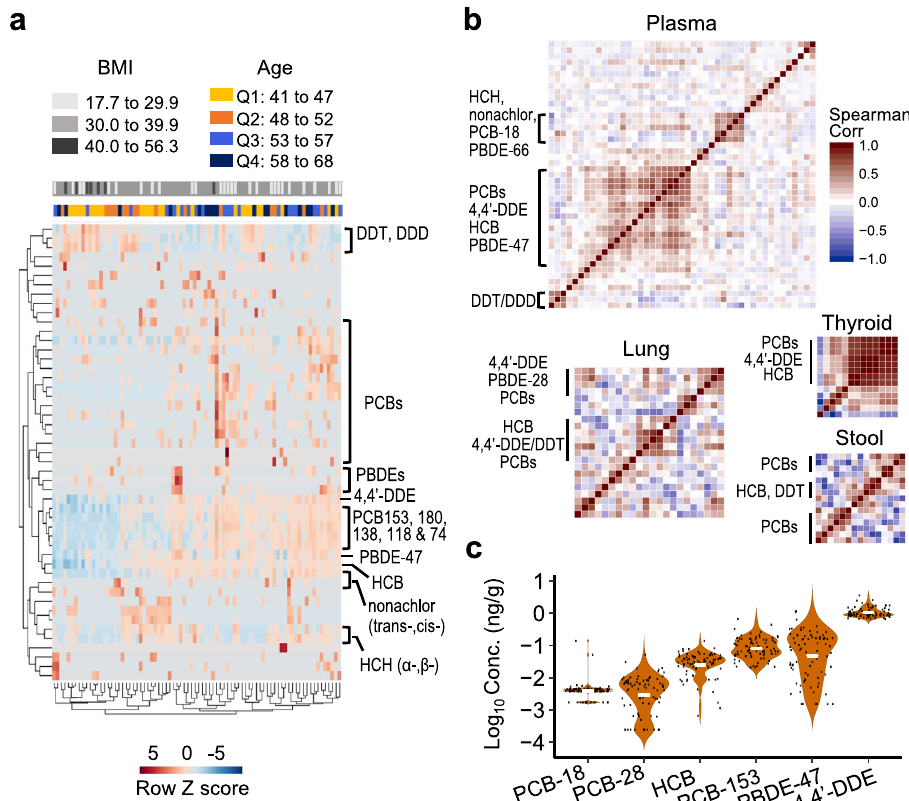
Fig. 4 XLE with GC – HRMS supports detection and quanti fi cation of environmental chemicals in different biologic materials. a Human plasma from 80 individuals without known occupational or environmental exposures of concern was analyzed for 49 chemicals and visualized by unsupervised two-way hierarchical clustering of log-transformed intensities. Subjects were color-coded into three body mass index (BMI) groups and age quantiles (Q1 – Q4). The results show that high-throughput analysis of environmental chemicals enables study of relationships of chemical distributions and associations with health characteristics. b XLE supports quanti fi cation of environmental chemicals in human plasma ( n = 80 biologically independent samples), lung ( n = 11 biologically independent samples), thyroid ( n = 5 biologically independent samples), and stool ( n = 6 biologically independent samples) samples. Hierarchical cluster analysis of Spearman ’ s correlation among quanti fi ed environmental chemicals shows co-exposure of different chemical classes and illustrates that XLE supports quanti fi cation of multiple classes of chemicals in different tissue types for integrative analyses of diverse chemical exposures. c Concentrations and distribution of chemicals prevalent in plasma (n = 80 biologically independent samples) samples shows that XLE is suitable to support quanti fi cation in human plasma (white bar — median; black dot — individual sample concentration). DDD dichlorodiphenyldichloroethane,